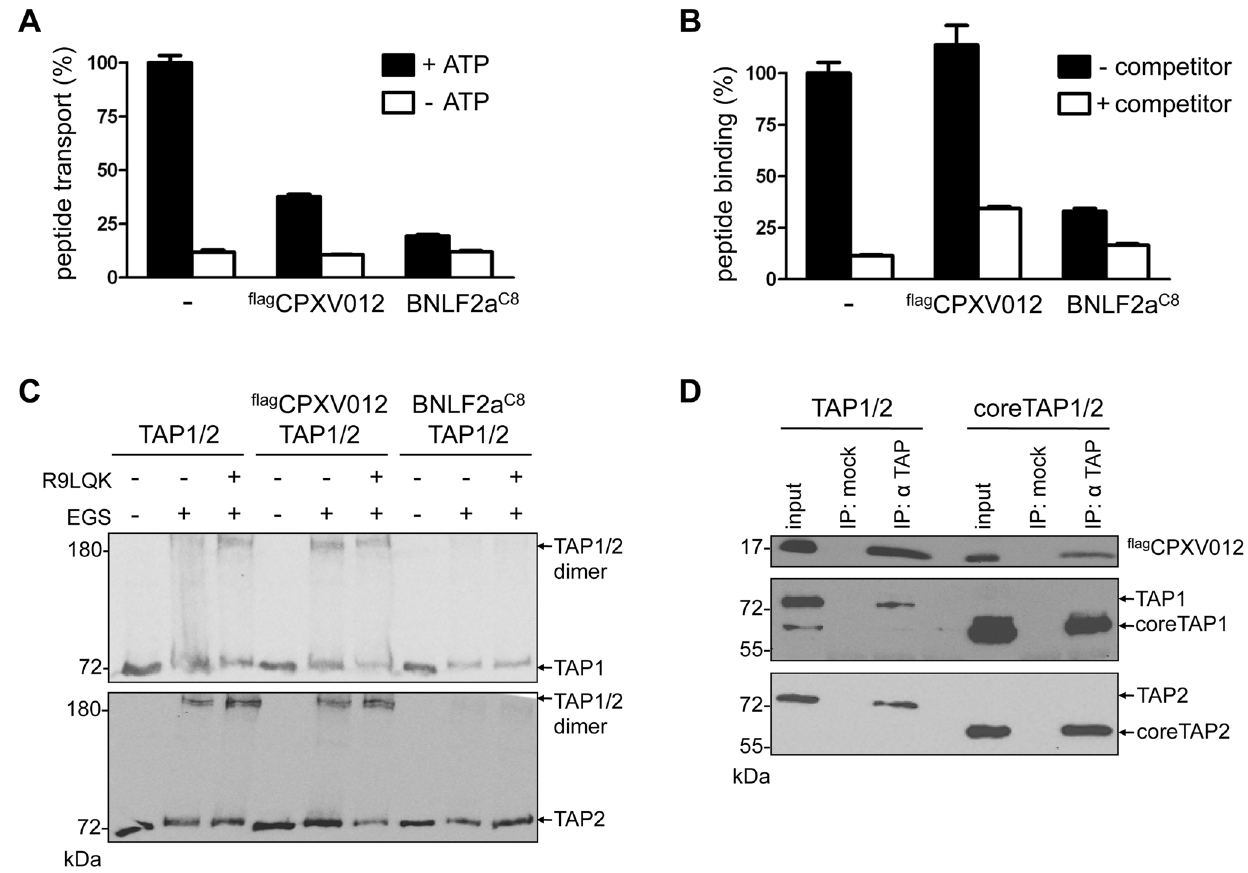
Fig. 2. CPXV012 inhibits peptide transport but not peptide binding to TAP. TAP1, TAP2, flag CPXV012, and BNLF2a C8 were coexpressed in Sf 9 cells as indicated. (A) CPXV012 inhibits peptide transport of TAP. Crude membranes were incubated with RRYQNSTC (F) L peptide (C (F) , fluorescein- labeled cysteine; N-core glycosylation site underlined) in the absence or presence of ATP. Translocated and N-core glycosylated peptides were bound to ConA-beads and quantified by fluorescence. Peptide transport by TAP was normalized to 100%. The means of at least three independent experiments are shown. Error bars indicate the S.D. (B) CPXV012 does not inhibit peptide binding to TAP. Crude membranes were incubated with high-affinity peptide RRYC (F) KSTEL (filled bars). A 100-fold excess of RRYQKSTEL (R9LQK) was used to probe for unspecific binding (open bars). Bound peptides were quantified by fluorescence. The membranes used for (A) and (B) expressed similar amounts of TAP1/2 (S1 Figure). (C) CPXV012 does not interfere with a peptide-induced conformational change of TAP. Membranes were incubated in the presence or absence of the peptide R9LQK. After EGS cross-linking, samples were analyzed by SDS-PAGE (6%) and immunoblotting with TAP1 (mAb 148.3) and TAP2 (mAb 435.3) specific antibodies. (D) CPXV012 binds to coreTAP. flag CPXV012 was coexpressed with either full-length TAP1/2 (left) or coreTAP1/2 (right). Proteins were immunoprecipitated with a mixture of polyclonal TAP1 (1p2) and TAP2 specific (2p4) antibodies (IP). The anti-US6 antibody was used a negative control (mock). Samples were analyzed by SDS-PAGE (12%) and subsequent immunoblotting with either anti-flag, monoclonal anti-TAP1 (mAb 148.3), or anti-TAP2 (mAb 435.3) antibodies. An aliquot (1/20) of the crude membrane input is shown.